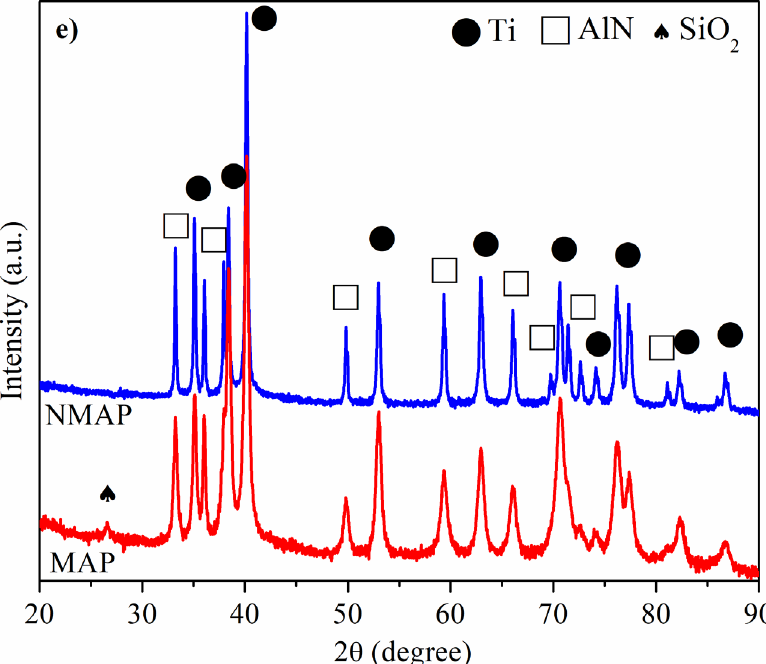
Figure 1. SEM images of powders: ( a ) as-received Ti, ( b ) as-received AlN, ( c ) Non-Mechanically Activated Powder mixtures (NMAP) and, ( d ) Mechanically Activated Powder mixtures (MAP); ( e ) XRD of NMAP and MAP powder mixtures.